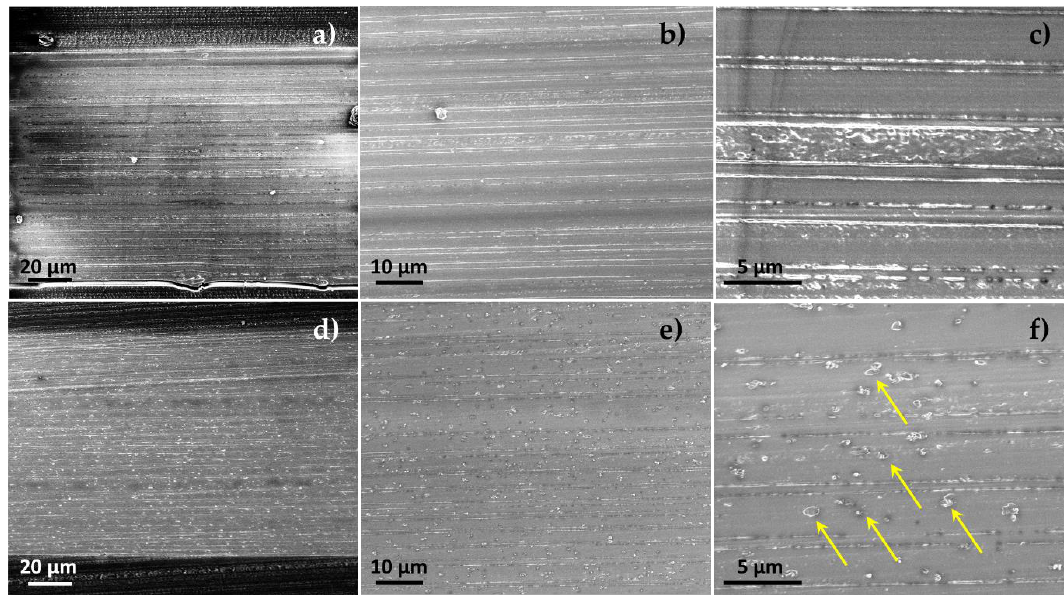
Figure 2. HR-SEM images of cryo-fractured cross-sections of ( a-c ) a 65-layer (low-density polyethylene (LDPE)/carvacrol)/ethylene vinyl alcohol copolymer (EVOH) film; and ( d-f ) a 65-layer (LDPE/[halloysite nanotubes (HNTs)/carvacrol])/EVOH film, at a low magnification demonstrating the entire film thickness, medium and higher magnifications. HNTs appear to be finely dispersed in the LDPE layer, marked by arrows for clarity. Note that the films were cross-sectioned in the transverse direction.